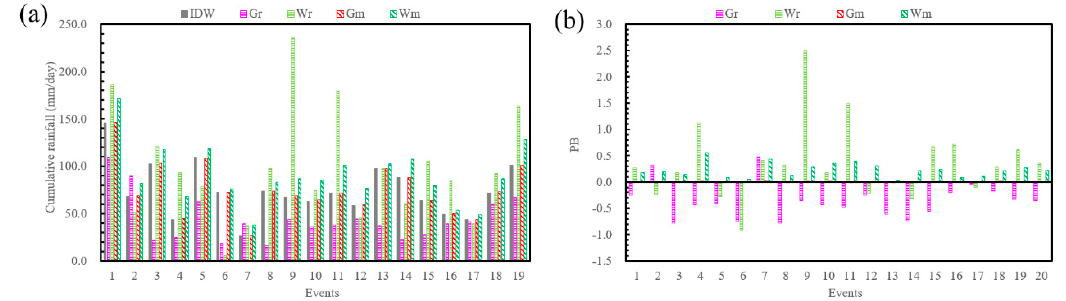
Figure 3. Cumulative rainfall ( a ) of the Inverse Distance Weight (IDW), GLDAS-derived rainfall (Gr), WRF-derived rainfall (Wr), GLDAS-merged rainfall (Gm) and WRF-merged rainfall (Wm) and the percent bias (PB) ( b ) of last four rainfall products. The last columns in (b) represents the PB mean-values of 19 events.